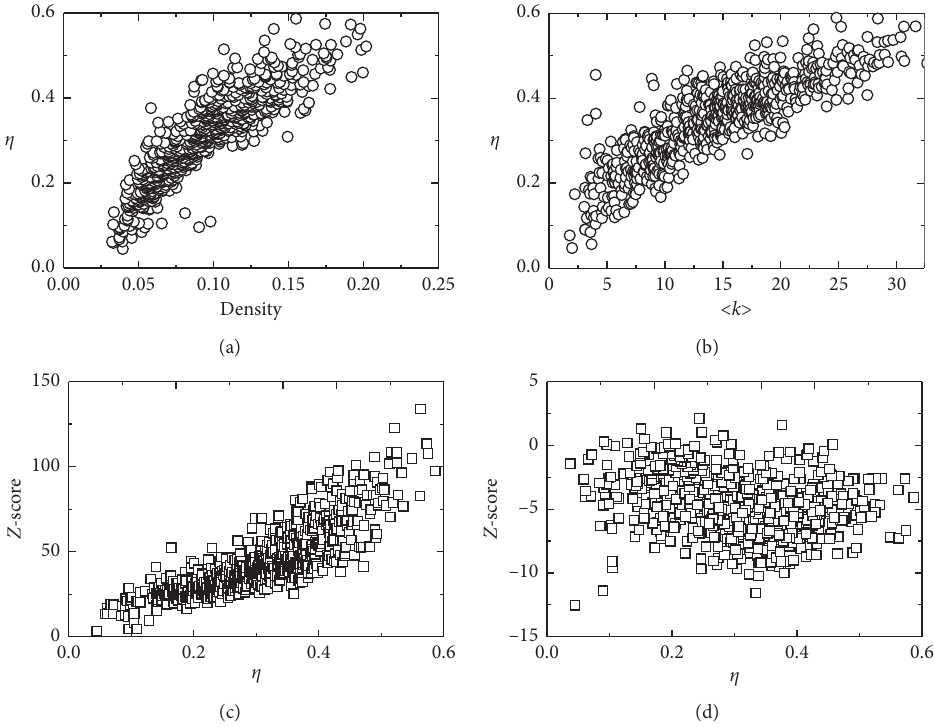
Figure 5: The relations with network density and degree sequence. (a) The relationship between density and nestedness. (b) The relationship between degree and nestedness. (c) z -score in the “swappable rows, swappable columns” (SS) null model. (d) z -score in the “fixed in-degree, fixed out-degree” (FF) null model. The higher the z -score value, the more different the nestedness of the original network is from the randomized network according to the null